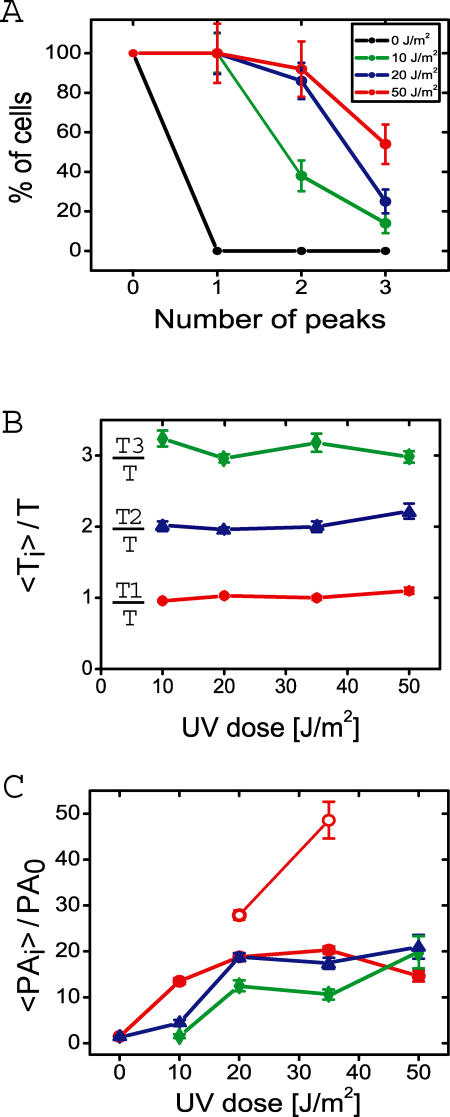
Dependence of Response Parameters on UV Dose(A) Percentage of cells exhibiting at least zero, one, two, or three peaks at different damage levels. (B) Dependence of the mean peak time <Ti>, normalized by T = (1/TD + 1/τ)–1 (τ = 68 min), on UV dose. (C) Dependence of the mean normalized peak height <PAi>/PA0 on UV dose. Wild type (full symbols), ΔumuDC (empty symbols). Same color and symbol convention as in (B): <PA1>/PA0 (red circles), <PA2>/PA0 (blue triangles), and <PA3>/PA0 (green diamonds). In wild-type cells, the amplitude of peaks saturates at approximately 20 PA0 for UV doses greater than 20 J/m2. ΔumuDC cells do not show this saturation and reach much higher PA levels. Parameters in (A), (B), and (C) are from measurements performed with the recA promoter.